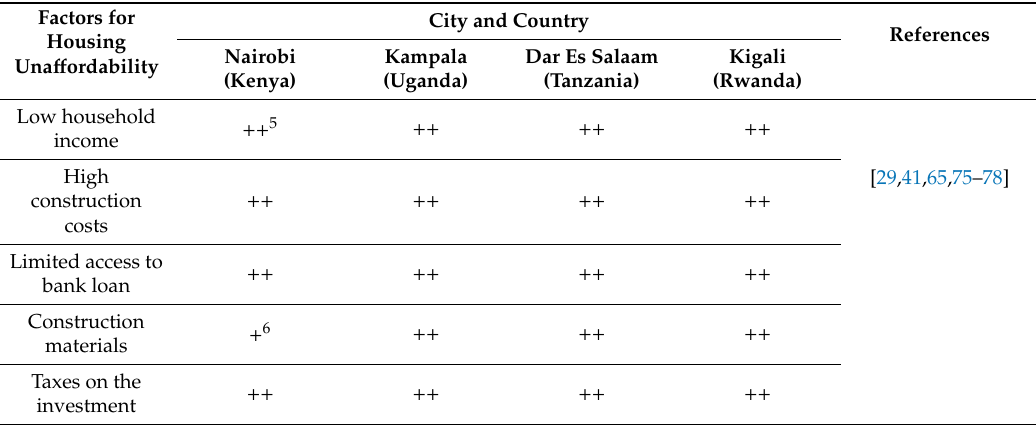
Table 7. Main factors a ff ecting the high cost of a housing unit in Eastern